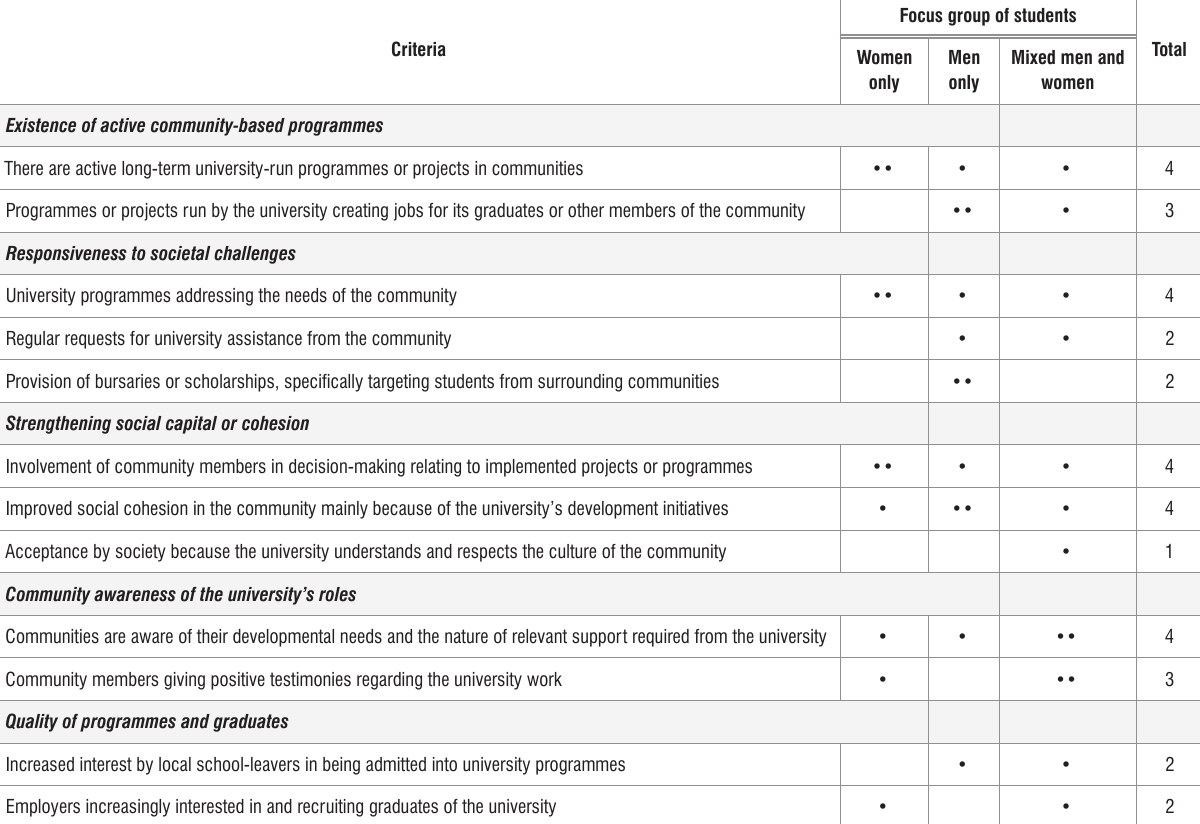
Table 2: Criteria for use in assessing the relevance of a South African rural-based university in community development